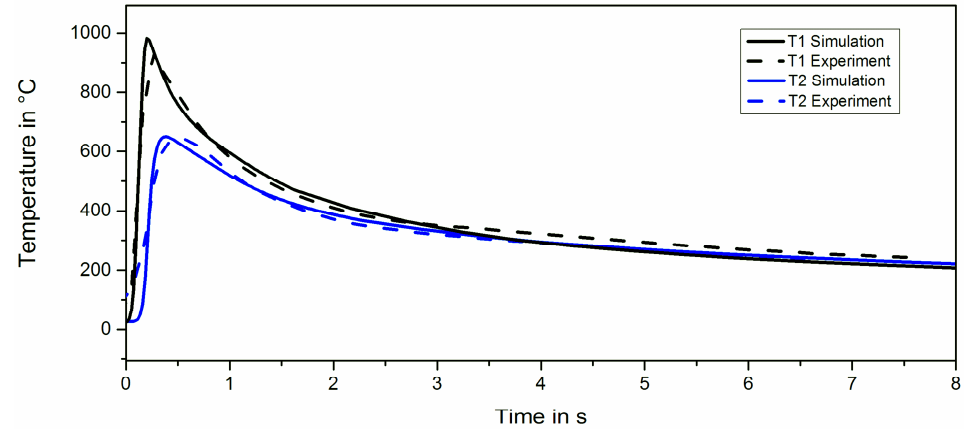
Figure 9. Comparison of the temperature measurements between experiments and the computational model.